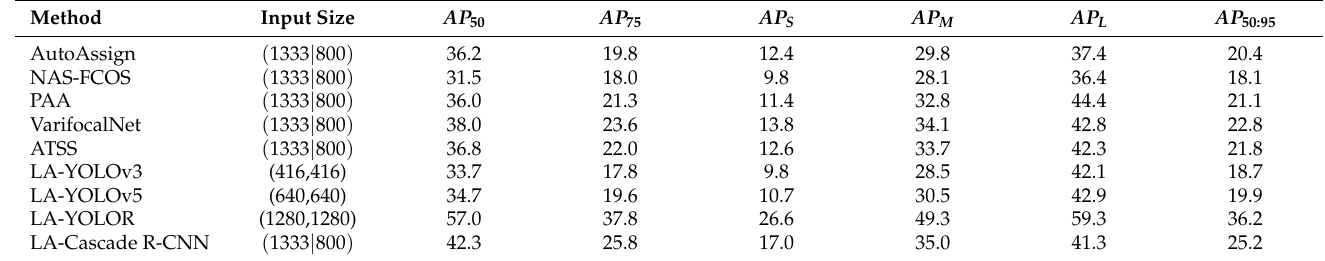
Table 9. The detection performance of different detectors on the VisDrone